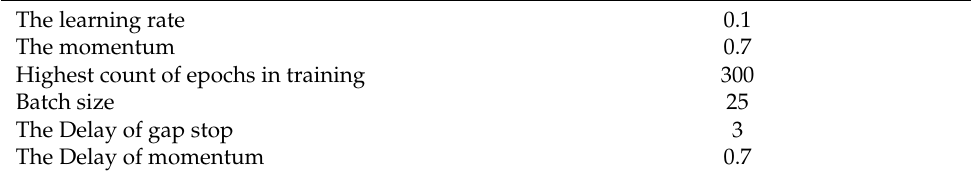
Table 1. The hyper-parameters in